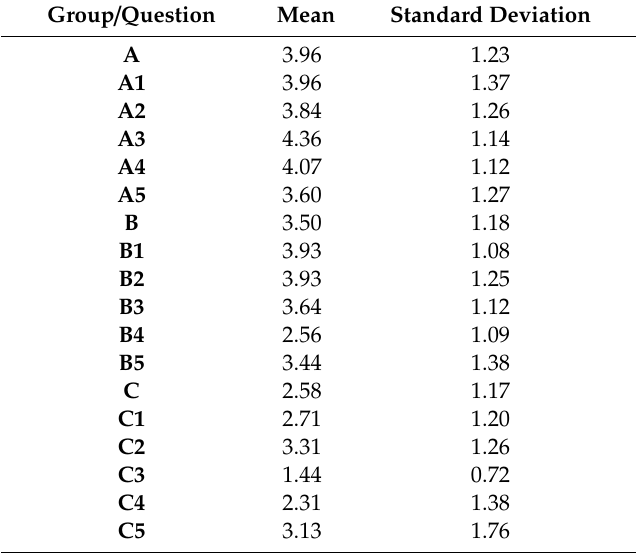
Table 6. Statistics of questions and individual groups of questions (own